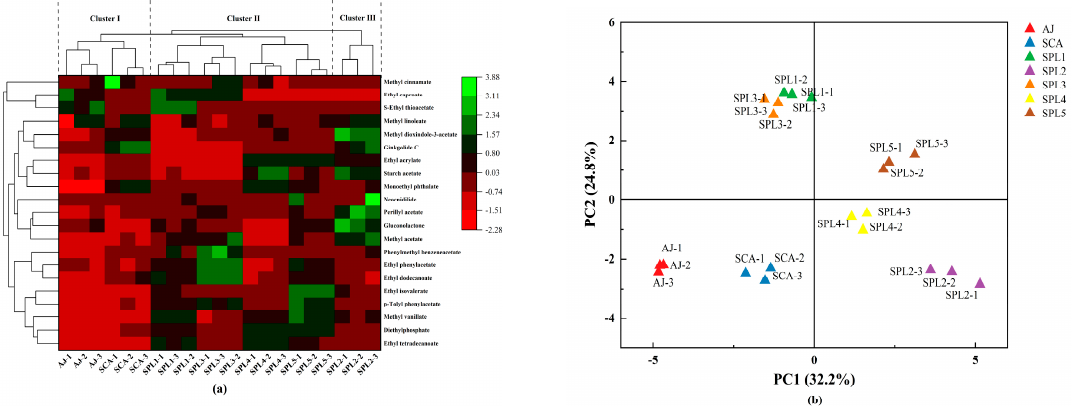
Figure 2. Compounds determined by GC-MS in apple juice and ciders. ( a ) Cluster heatmap of easter compounds in apple juice and ciders. ( b ) Principal component analysis (PCA) based on esters, higher alcohols, aldehydes, and ketones of apple juice and apple ciders.